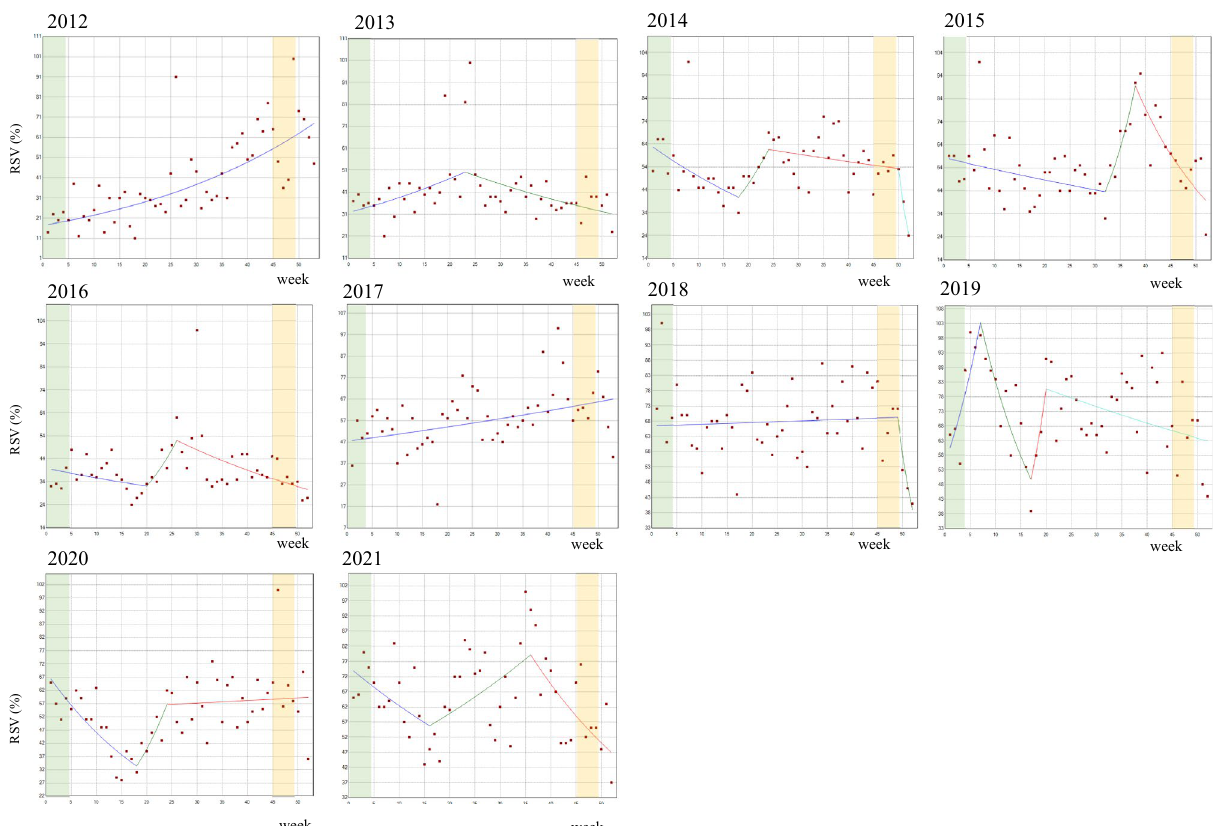
Figure 3. Weekly trend change analysis of relative search volumes in Google Trends by joinpoint regression in the “All” category by year from 2012 to 2021. The cervical cancer awareness month (CCAM) is depicted in green (week 1 st to 4 th ). The cervical cancer prevention awareness enhancement month (CCPAEM) is highlighted in yellow (week 45–48). Joinpoints are the time points at which statistically significant changes ( p < 0.05) in the linear slopes were noted. Detailed data are presented in Table 2.